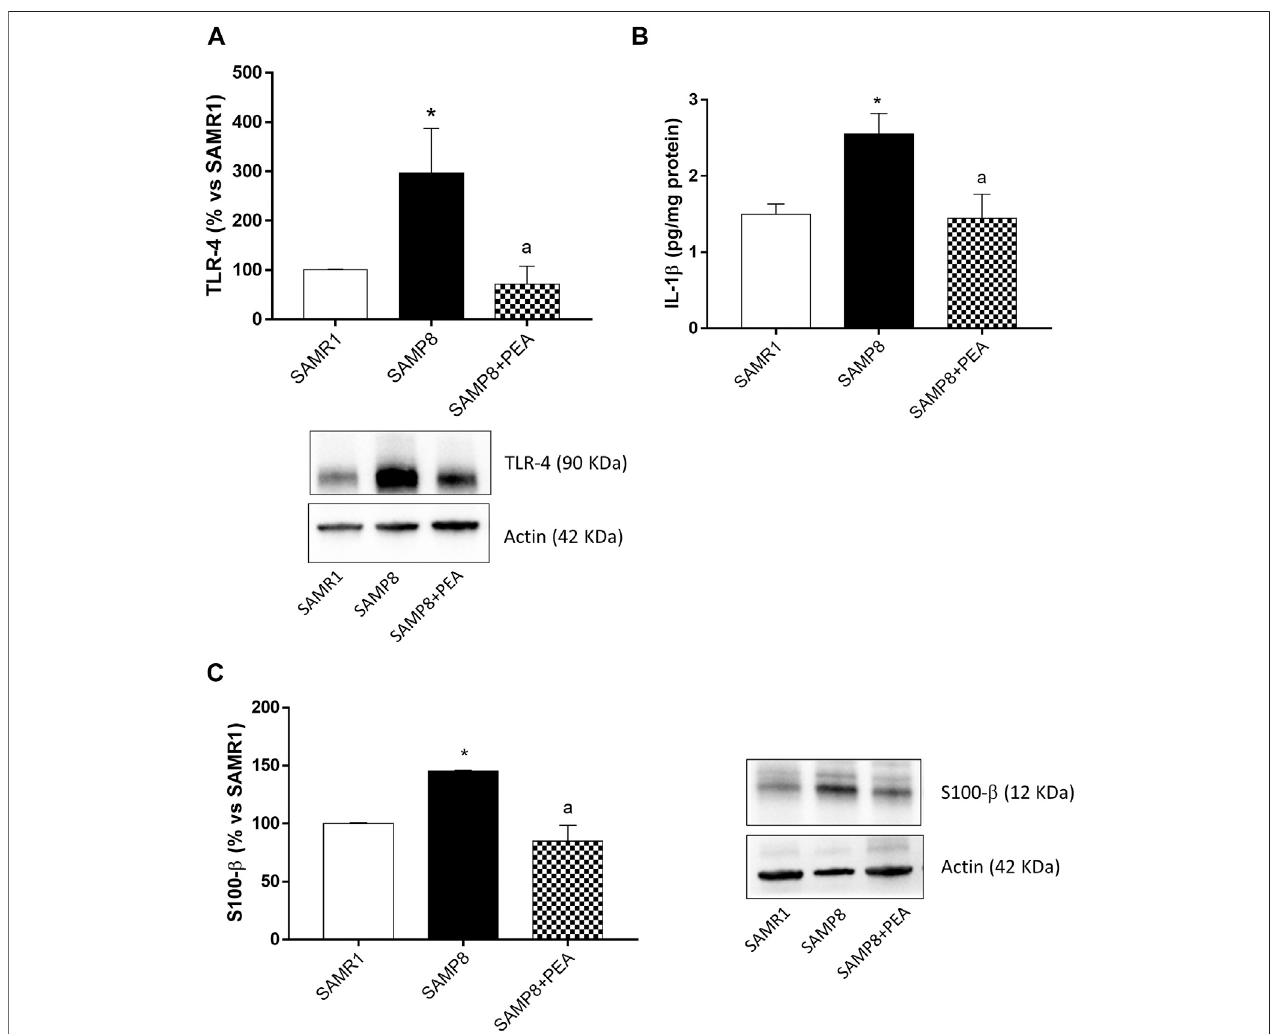
FIGURE 4 | PEA counteracts the intestinal in fl ammation and enteric gliotic process associated with cognitive decline. (A) Representative blots and densitometric analysis of the expression of TLR-4 in colonic tissues from SAMR1, SAMP8 and SAMP8 treated with PEA; (B) IL-1 β levels in colonic tissues from SAMR1, SAMP8 and SAMP8 treated with PEA and (C) representative blots and densitometric analysis of glial marker, S100- β , in colonic tissues from SAMR1, SAMP8 and SAMP8 treated withPEA.Eachcolumnrepresentsthemean ± SEMfromfouranimals.One-wayANOVAfollowedbyTukeyposthoctestresults:* p < 0.05,signi fi cantdifferencevs. SAMR1 and a p < 0.05, signi fi cant difference vs. SAMP8.; Abbreviations : IL-1 β , interleukin-1 β ; PEA, palmitoylethanolamide; S100- β , S100 Calcium Binding Protein B; SP, substance P; TLR-4, Toll-like Receptor 4.